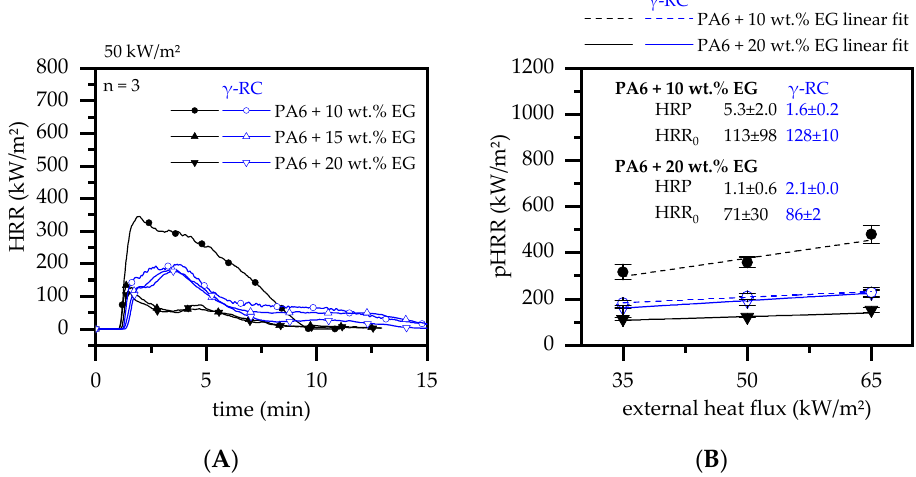
Figure 12. ( A ) HRR curves conducted by cone calorimeter testing for net and β -radiation β -RC PA6/EG formulations at 50 kW/m 2 . ( B ) pHRR conducted by cone calorimeter tests at external heat fluxes of 35, 50 and 65 kW/m 2 . A linear fit was used to evaluate the HRP and corresponding y-cross point HRR 0 .